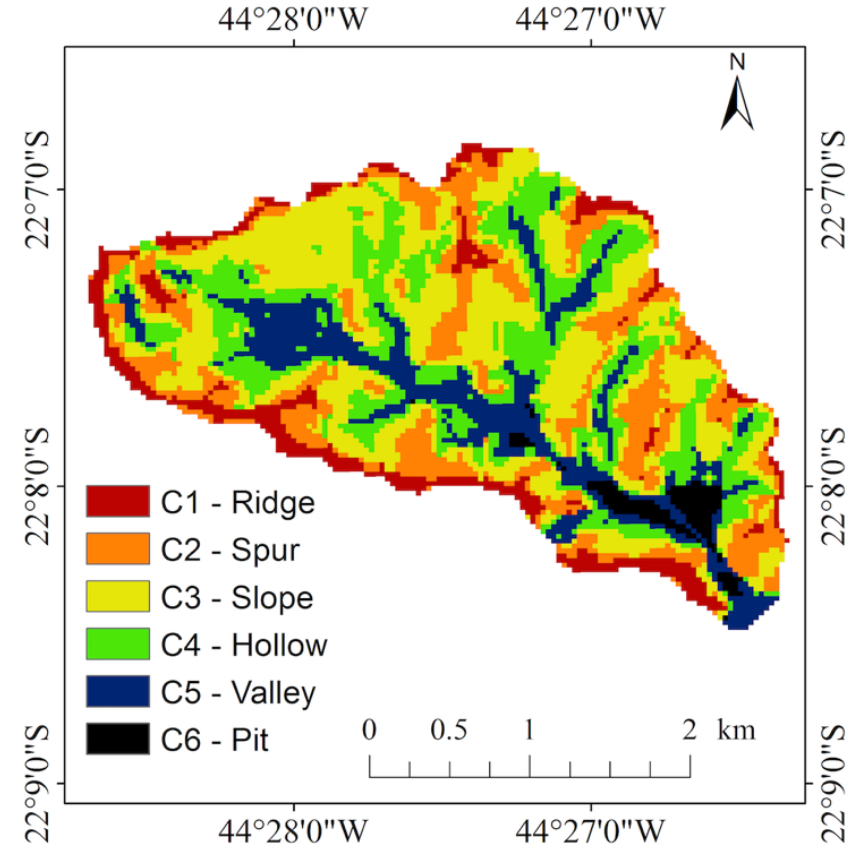
Figure 4. Geomorphons features obtained for the Lavrinha Creek Watershed.